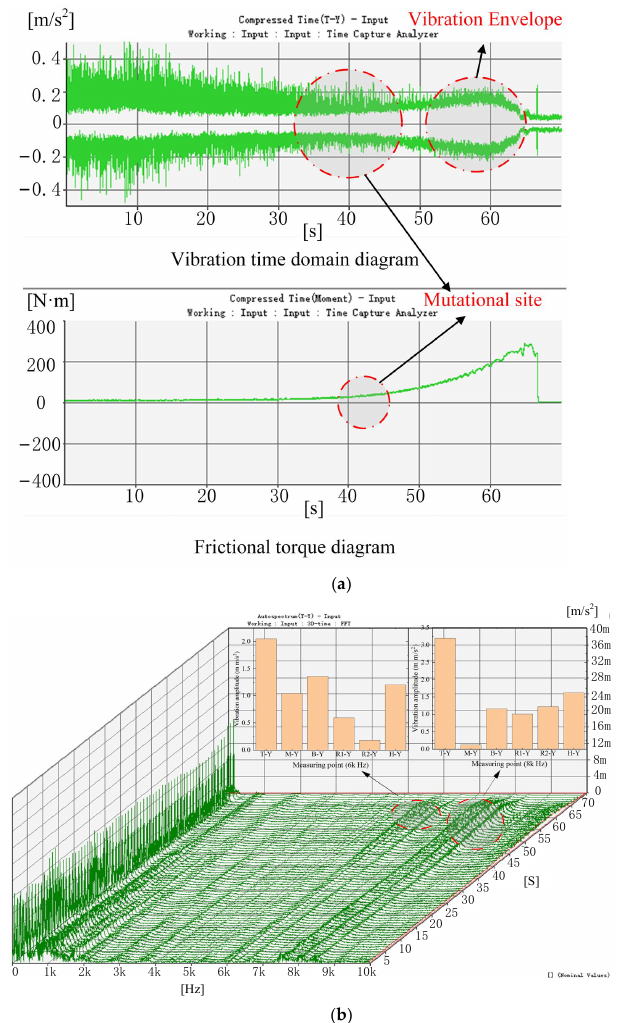
Figure 5. Friction induced vibration time-frequency domain diagram. ( a ) Frictional vibration time- domain diagram and torque diagram, ( b ) frictional vibration time-frequency diagram.